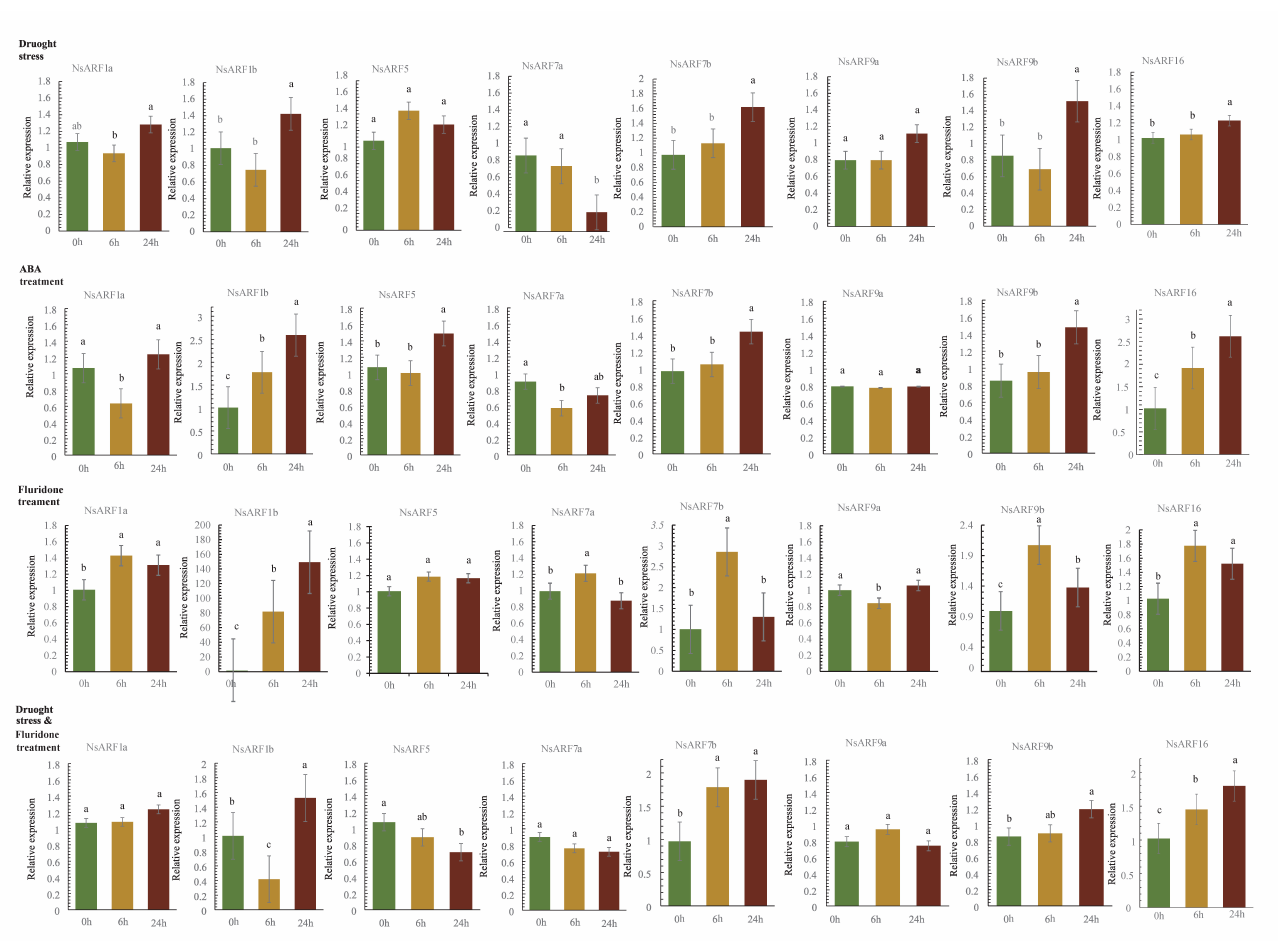
Figure 6. Expression profiles of NsARFs under abiotic stress. Values with the different letter (a–c) were significantly different when assessed using Duncan’s multiple range test ( p <